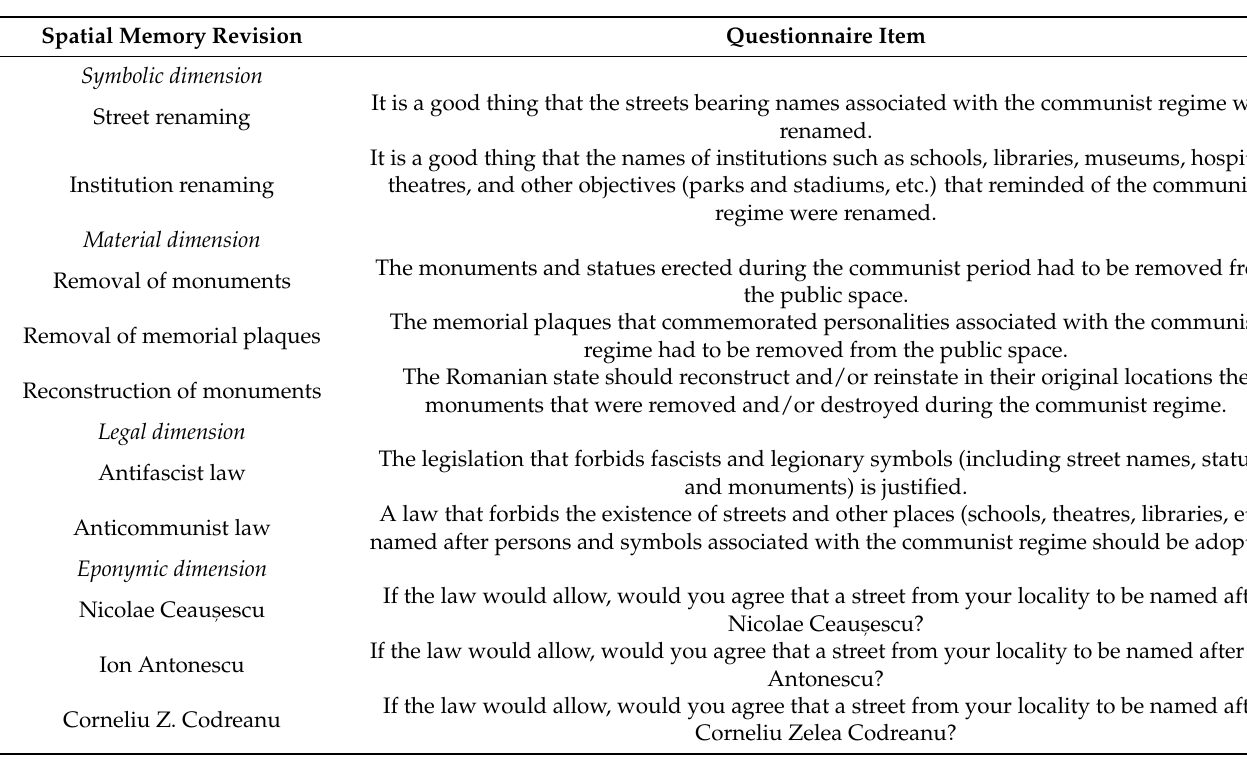
Table 1. Dependent variable: dimensions and